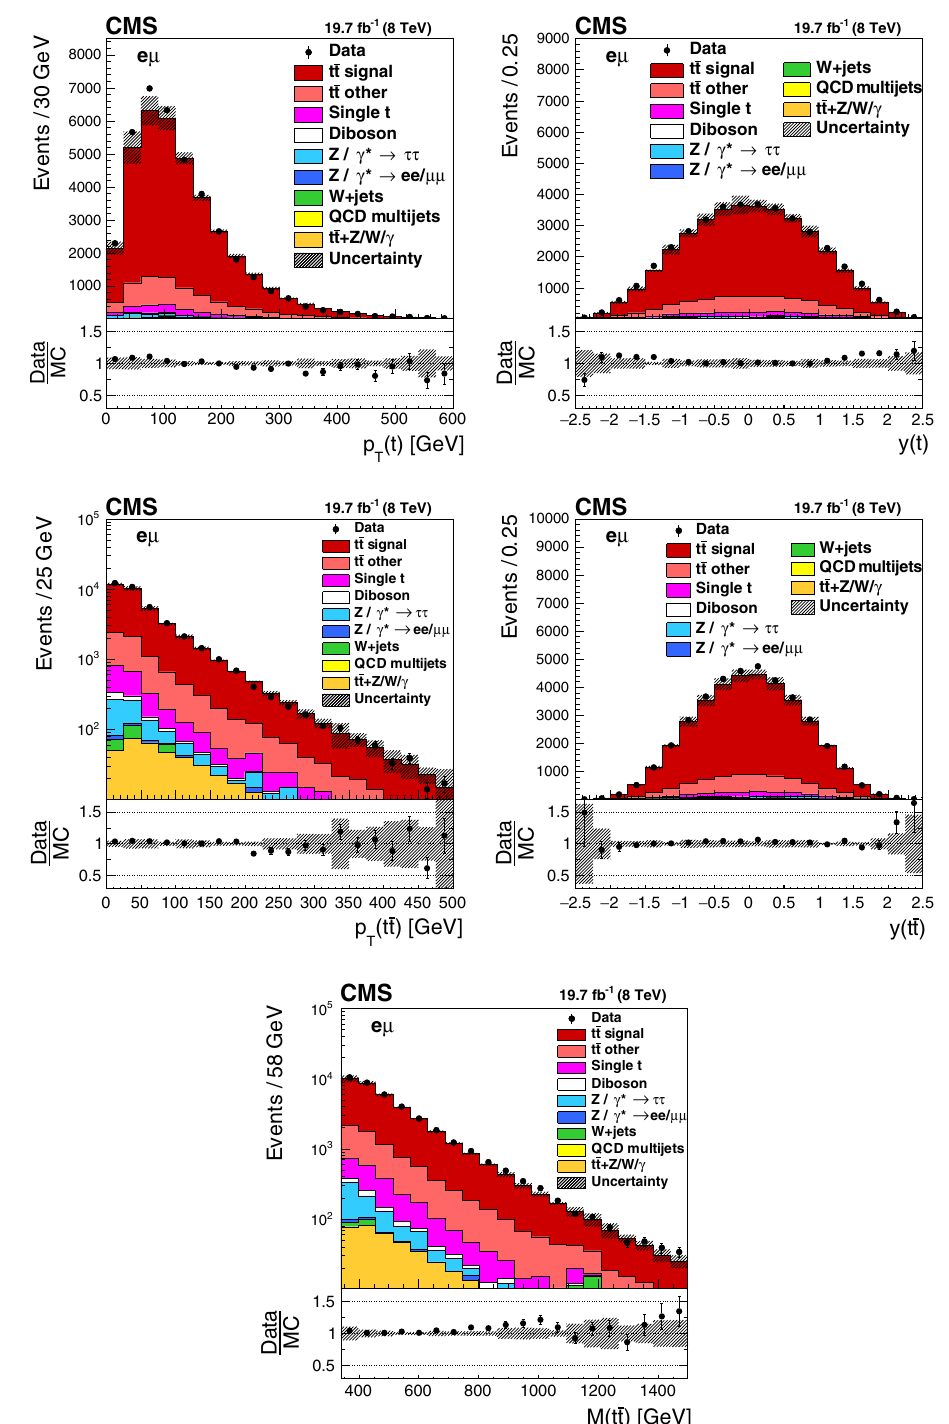
Fig. 1 Distributions of p T ( t ) ( upper left ), y ( t ) ( upper right ), p T ( tt ) ( middle left ), y ( tt ) ( middle right ), and M ( tt ) ( lower ) in selected events after the kinematic reconstruction. The experimental data with the vertical bars corresponding to their statistical uncertainties are plotted together with distributions of simulated signal and different background processes. The hatched regions correspond to the shape uncertainties in the signal and backgrounds (cf. Sect. 7). The lower panel in each plot shows the ratio of the observed data event yields to those expected in the